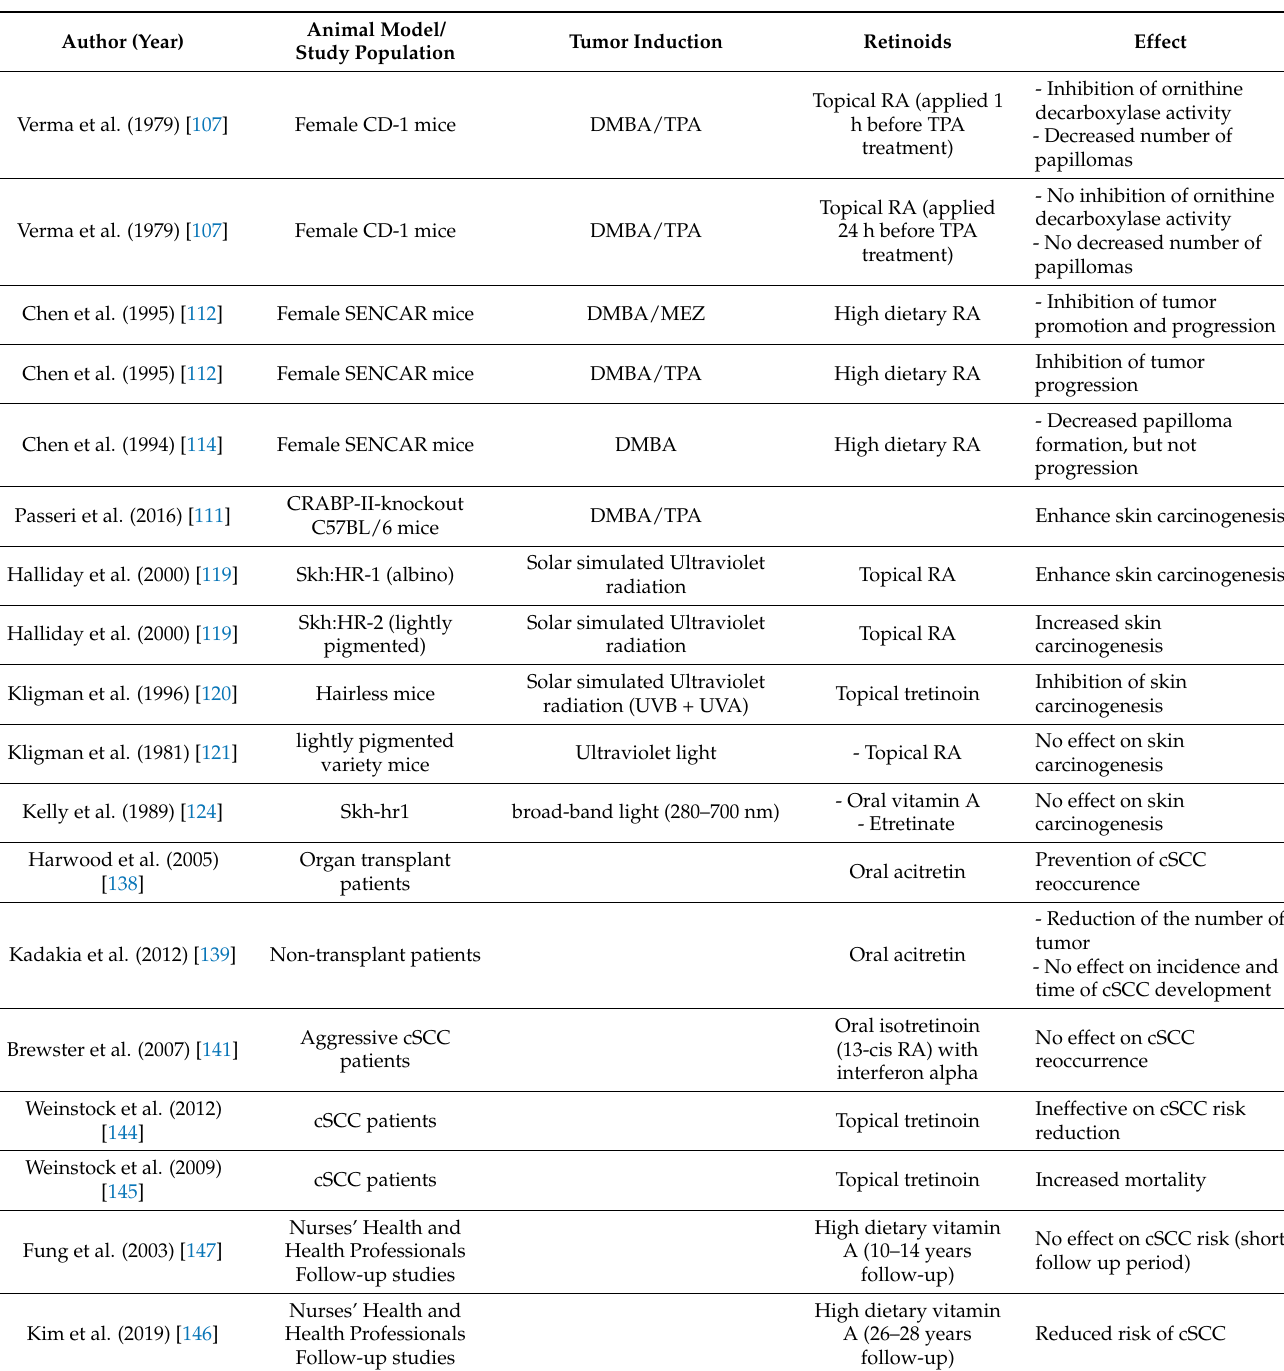
Table 3. Summary of exogenous retinoid effects on cutaneous squamous cell carcinoma